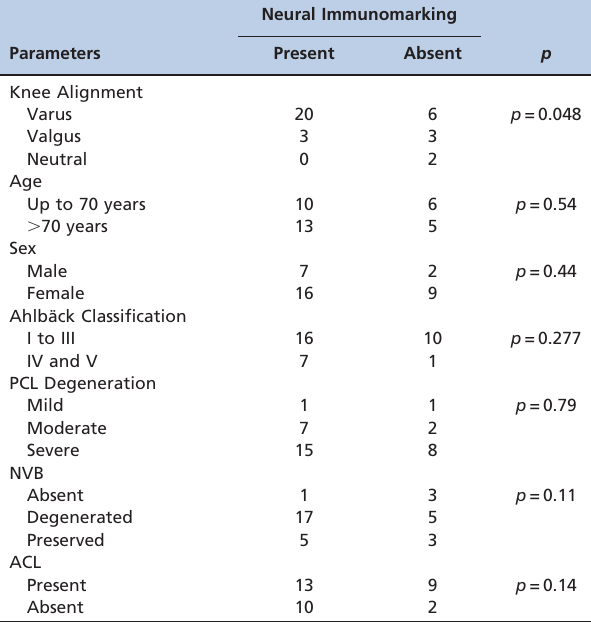
Table 1 - Correlation between the studied parameters and the immunomarking of the neural structures of the PCL.